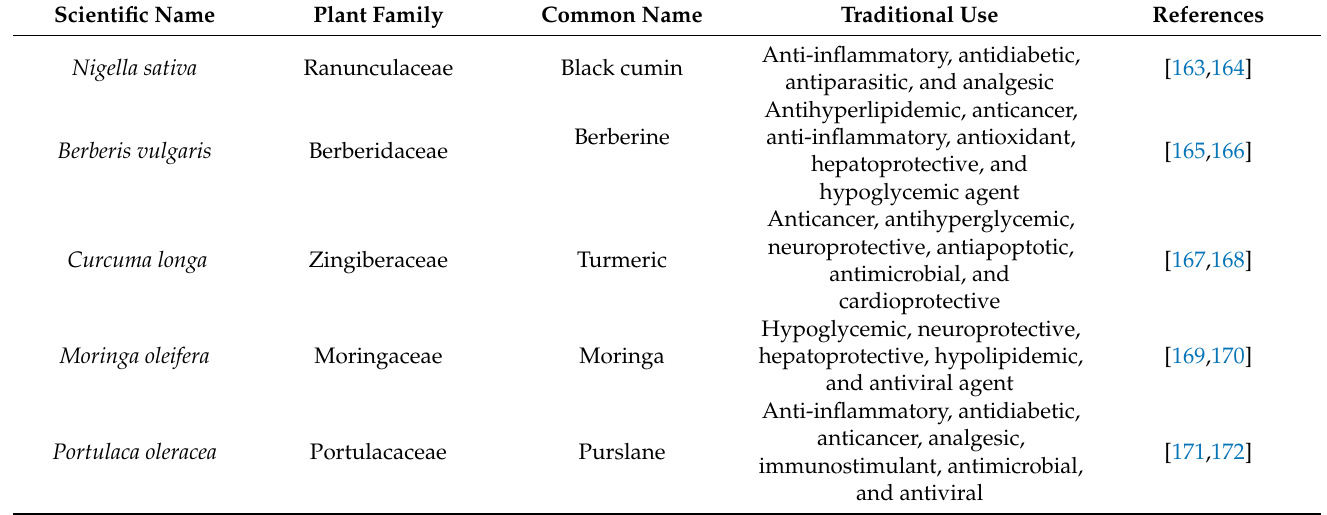
Table 1. Antidiabetic effect of medicinal plants.